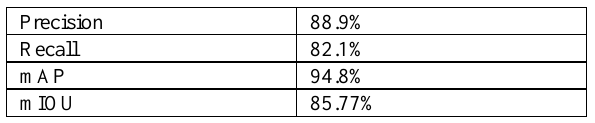
Table 1. Asset detection accuracy evaluation